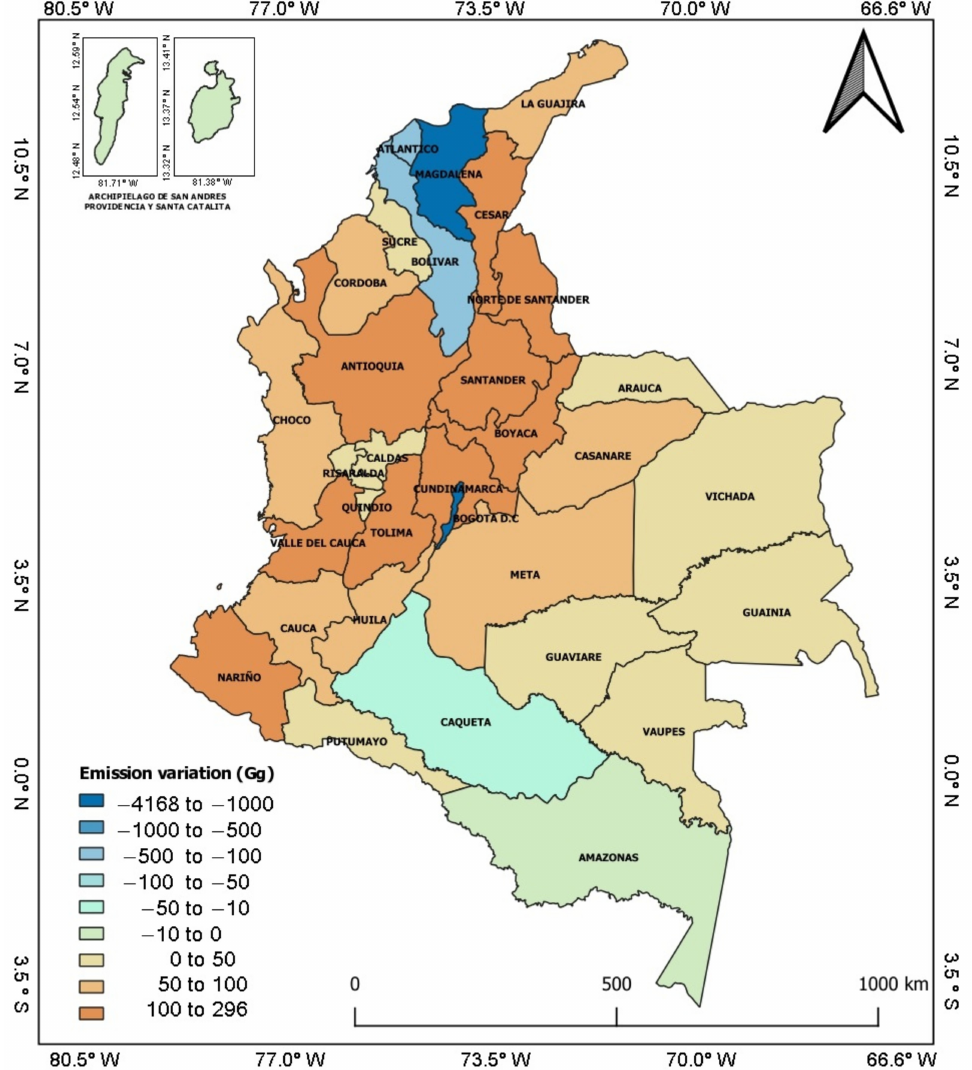
Figure 5. Spatial distribution of mean levels of tropospheric NO 2 through internal political and territorial divisions (departments) between April and June 2018 and 2020. Source: Time averaged map of NO 2 tropospheric column (30% cloud screened) daily 0.25 deg. (OMI OMNO2dv003) 1/cm 2